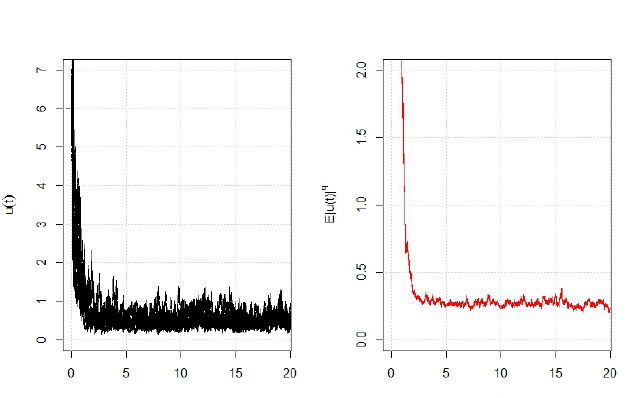
Figure 5. Trajectories of u ( t ) and E | u ( t ) | 2.1 for system (23) with c = 2 and sample size